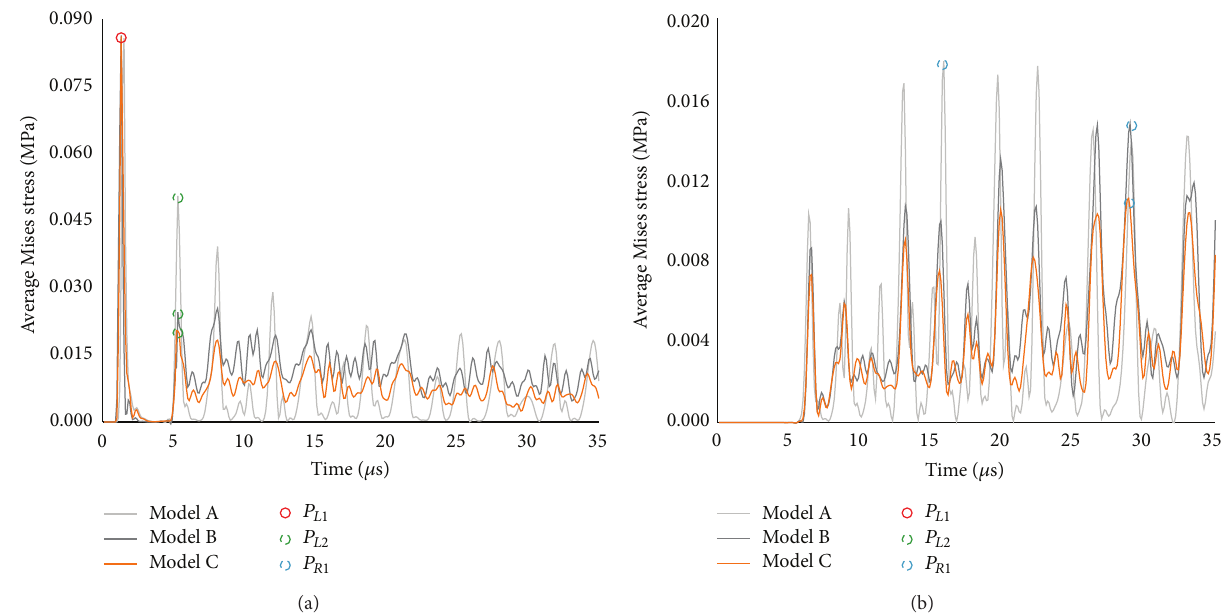
Figure 3: Time histories of the average Mises stresses at section 𝐿 - 𝐿 󸀠 (a) and at section 𝑅 - 𝑅 󸀠